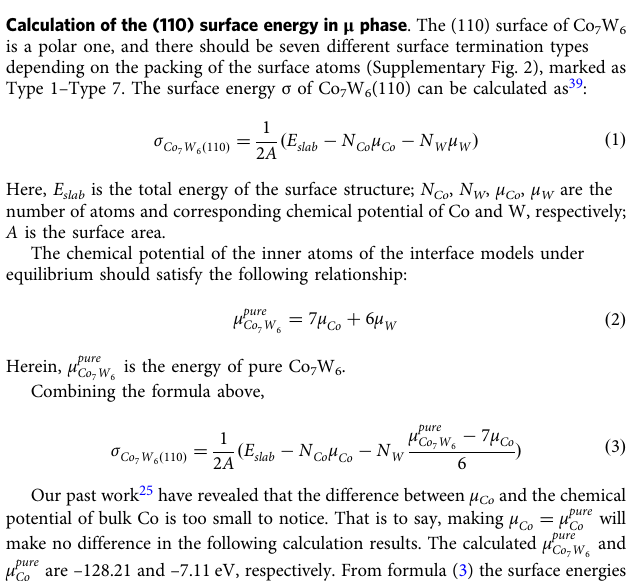
Fig. 4 The transformation from μ can lead to either the P or the σ phase. a The projected atomic arrangement of μ phase with one FTB; the FTB is marked with orange dotted line, both sides of the FTB are the perfect structure of μ phase with seven nonequivalent (110) layers. The thickness of the seven layers is de fi ned as block D. The purple and blue atoms represent (Co, Cr, Ni) and (W, Mo, Re), respectively. After the transformation displayed in Figs. 2 and 3, a changes to the partial structure of P (or σ ) phase (marked with framed boxes) in ( b , c ). The yellow atoms are the extra row of atoms that have diffused in. d The atomic arrangement showing two FTBs of μ phase with a spacing of D (between the two orange dashed lines). e , f The model and corresponding experimental HAADF image of defects in ( d ) after transformation, and the part in the dashed boxes are the complete intergrowth σ phase projected along [011] σ . g The atomic arrangement of two FTBs of μ phase with a spacing of 2D. h , i The model and corresponding HAADF image of defects in ( g ) after transformation, where the region inside the dashed boxes are the complete intergrowth P phase projected along [011] P . The HAADF image simulation of each structures are included as overlaid insets in ( c , f , i ),